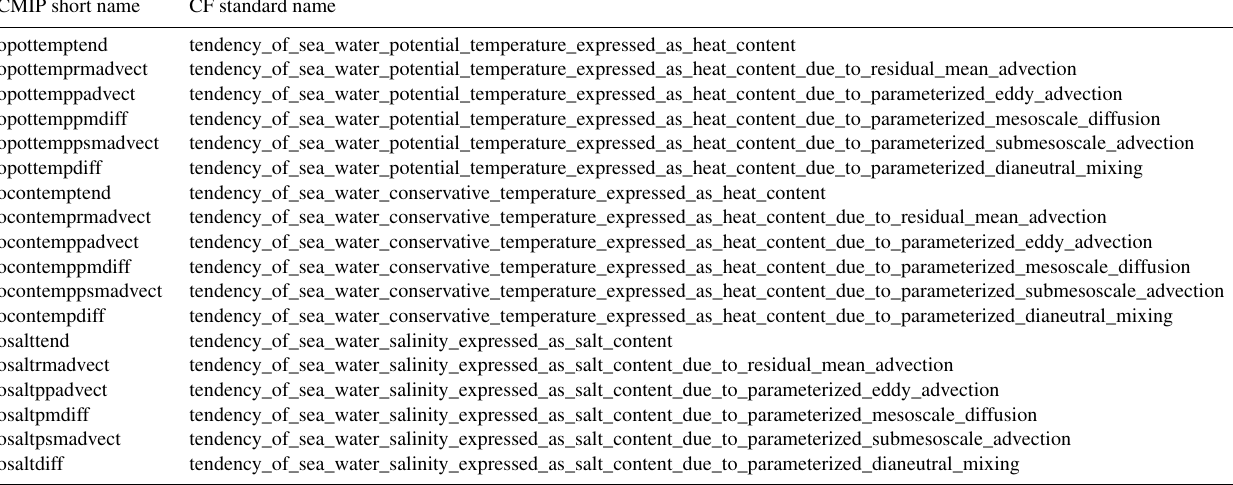
Table 4. New diagnostics for process-based ocean temperature and salinity tendencies, required by FAFMIP and described in detail in Sect. 9 of Griffies et al.